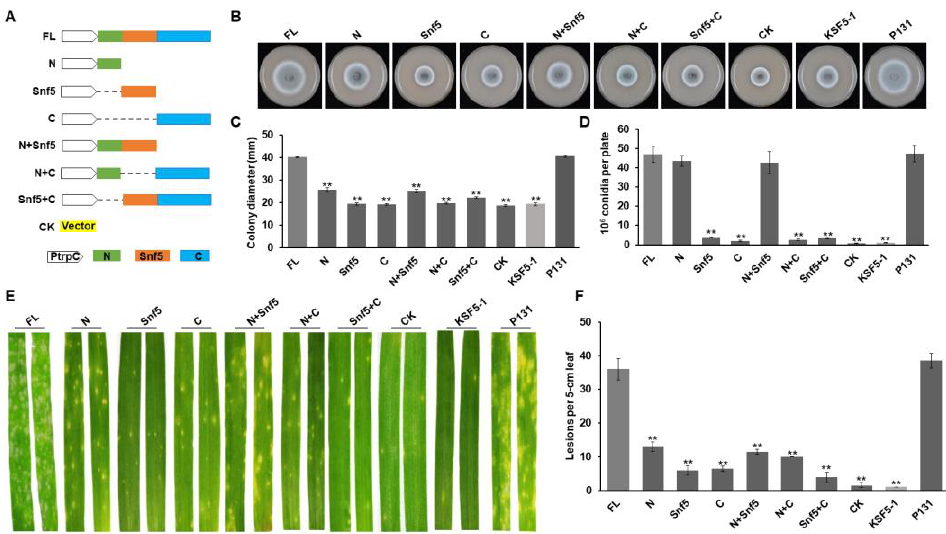
Figure 3. Domain dissection of MoSnf5. ( A ) Strategy on constructing domain deletion vectors of MoSnf5, including the N-terminal region (N), the Snf5 domain (Snf5), the C-terminal region (C), the deletion of the C-terminal region (N+Snf5), the deletion of the Snf5 domain (N+C), and the deletion of the N-terminal region (Snf5+C). The full-length (FL) allele was used as a positive control. The green, orange, and blue boxes represent the N-terminal region, the Snf5 domain, and the C-terminal region of MoSnf5, respectively. All MoSnf5 alleles were driven by the PtrpC promoter and transformed into the ∆ Mosnf5 mutant for phenotypic analysis. ( B ) Colonies of different alleles of MoSnf5 in ( A ) expressed in the ∆ Mosnf5 mutant, the ∆ Mosnf5 mutants KSF5 − 1, and the wild-type strain P131 cultured on OTA plate at 5 dpi. ( C ) Statistics on colony diameters of strains in ( B ) at 5 dpi. The mean and standard deviations were calculated based on three independent experiments by measuring three plates in each replicate. Asterisk marks a significant difference between the mutants and the P131 strain by using t -test ( p < 0.05). ( D ) Capacity on conidiation of strains in ( B ). The mean and standard deviations were calculated based on three independent experiments by measuring three plates in each replicate. Asterisk marks a significant difference between the mutants and the P131 strain by using t -test ( p < 0.01). ( E ) Barley seedlings sprayed with conidia of strains in ( B ). Typical diseased leaves were photographed at 5 dpi. ( F ) Bar graphs showing number of disease lesions on 5 cm rice leaf infected by strains in ( B ). The mean and standard deviations were calculated based on three independent experiments by measuring 10 diseased leaves in each replicate. Asterisk marks a significant difference between the mutants and the P131 strain by using t -test ( p < 0.05).